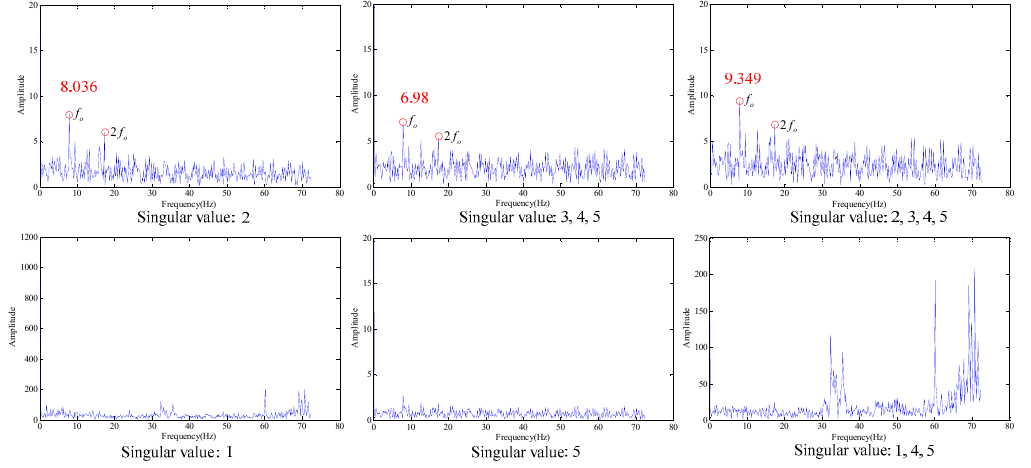
Figure 21. Filtering effect under different singular values.